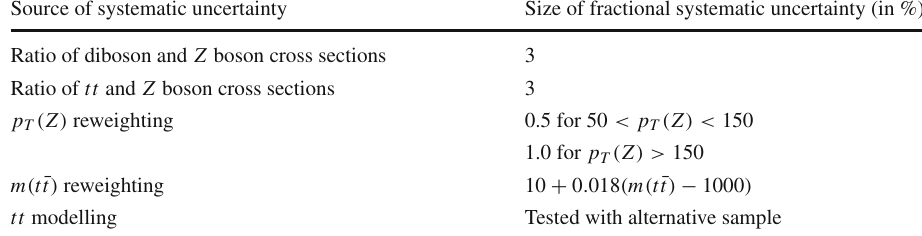
Tested with alternative